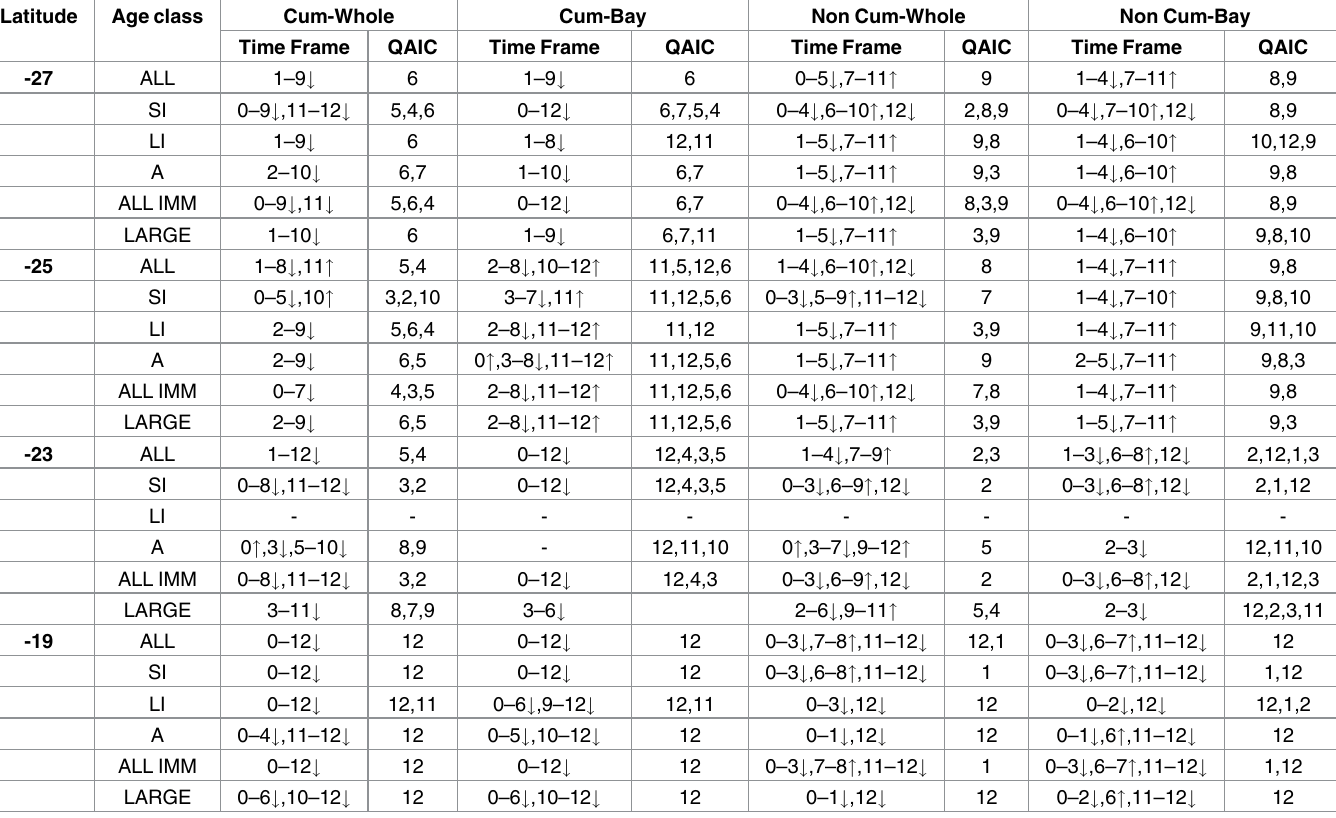
Table 13. Model results for all turtles and monthly mean maximum temperature. " denotesincreasedstrandingsrates with increasedmean maximum temperature. # denotesdecreased strandingrates with increasedmean maximum temperature. Age class abbreviations: ALL = all turtles, SI = small imma- ture, LI = large immatures, A = adult-sized, ALL IMM = all immature sized animals(small + large), Large = all large turtles (large immatures + adult-sized). The time frame is reportedin monthly rangeswhere responses were noted. The values reportedin qAIC are the months with the most significantqAIC value.